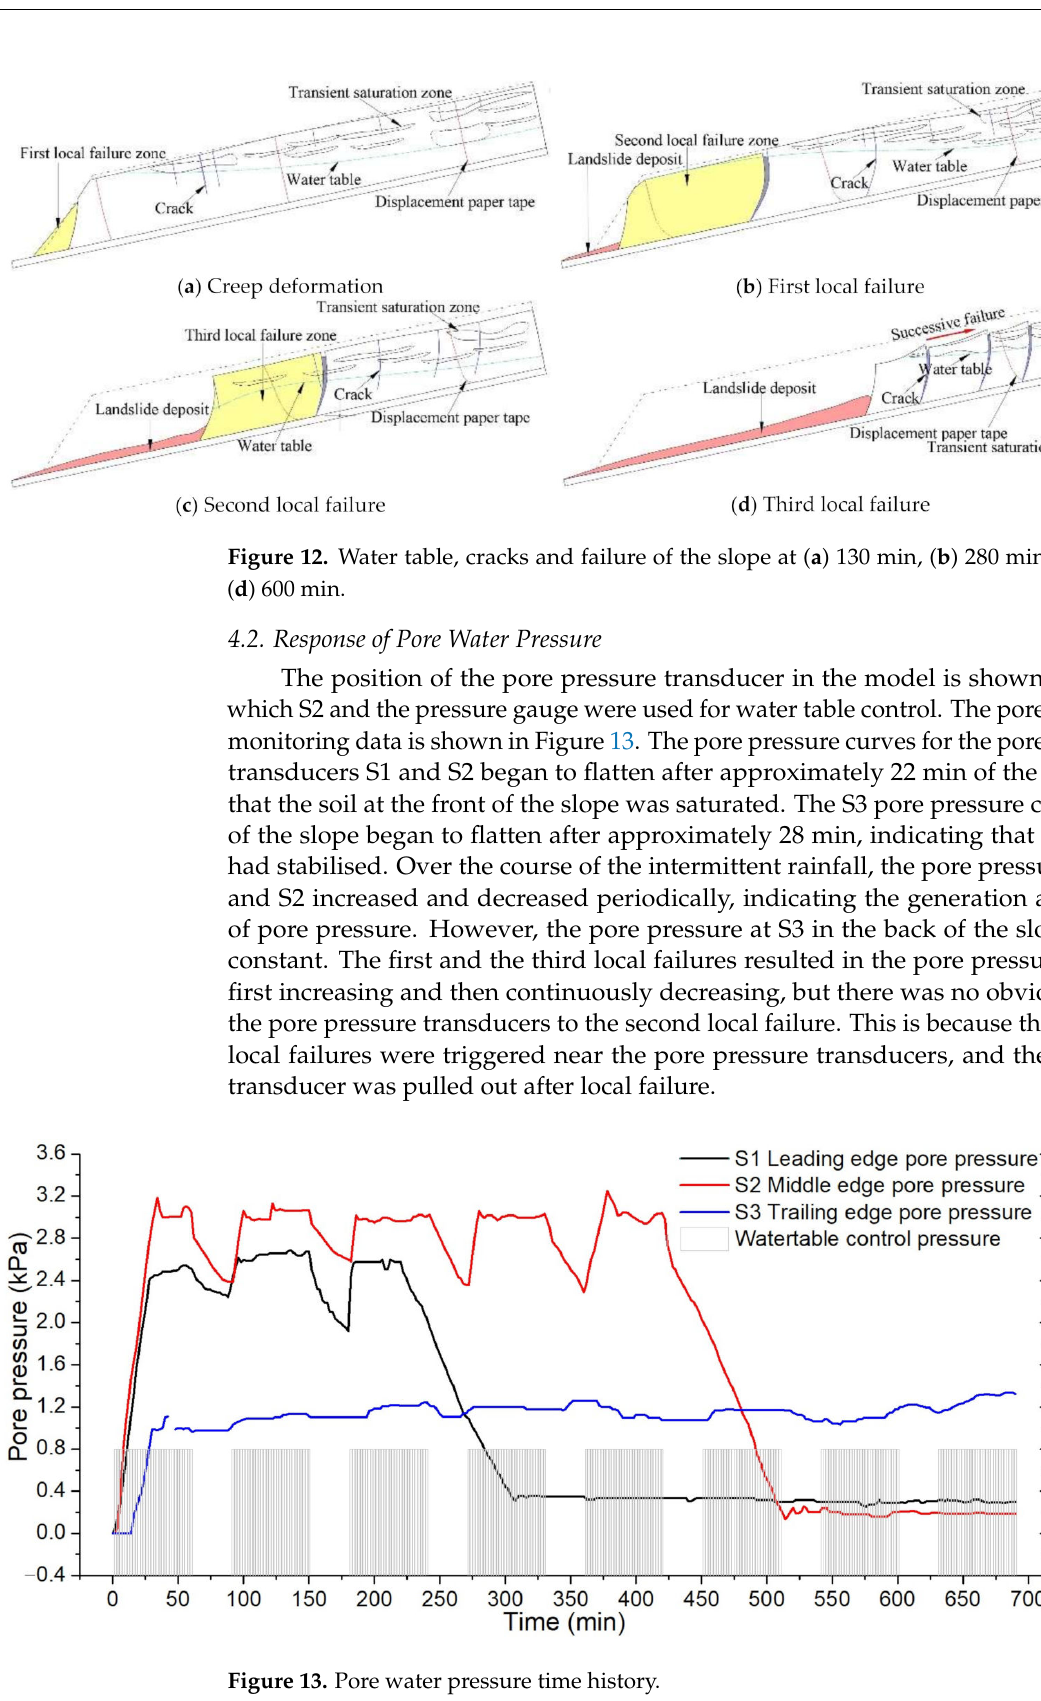
Figure 13. Pore water pressure time